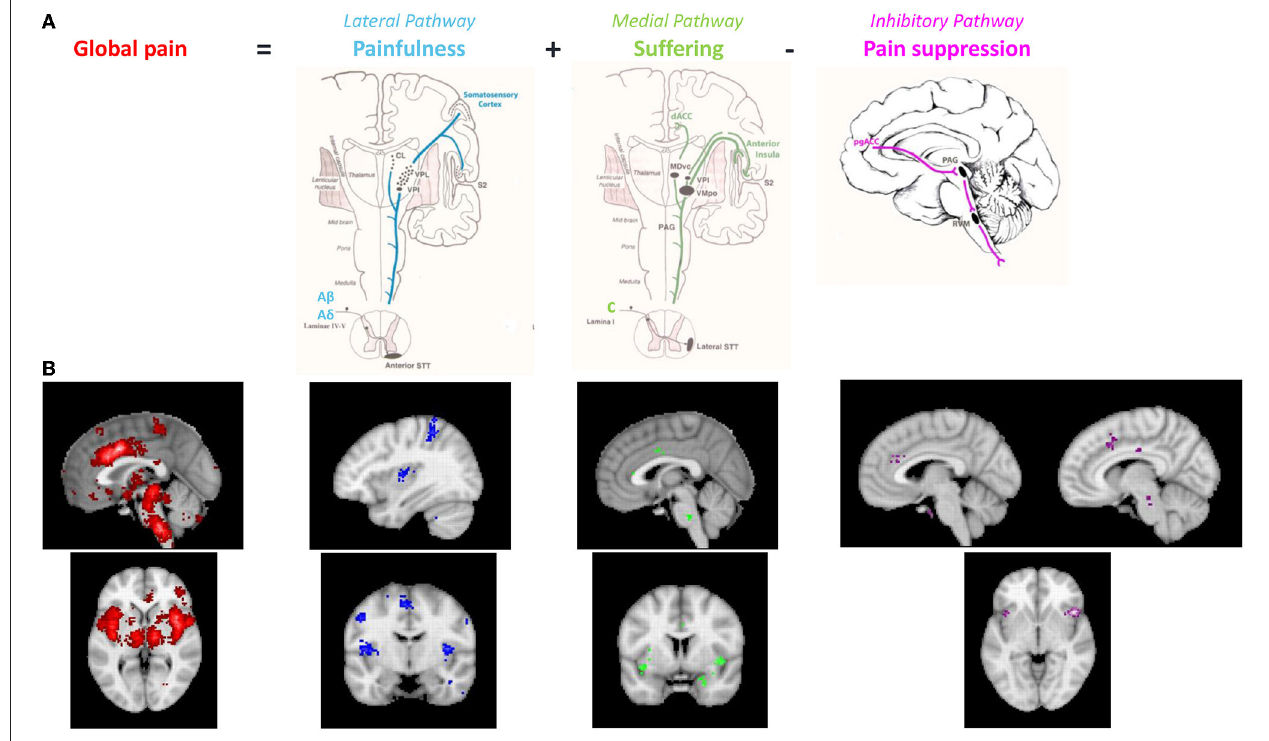
FIGURE 2 | (A) The anatomical pathways associated with 3 different aspects of pain (painfulness, suffering and presence). (B) Neurosynth meta-analyses of functional imaging studies evaluating the different components of the pain signature in the brain. Meta-analysis of pain ( n = 516 studies, red and blue), meta-analysis of suffering ( n = 124, green) and meta-analysis of inhibition ( n = 601, purple). Modified from reference De Ridder et al. ( 29).